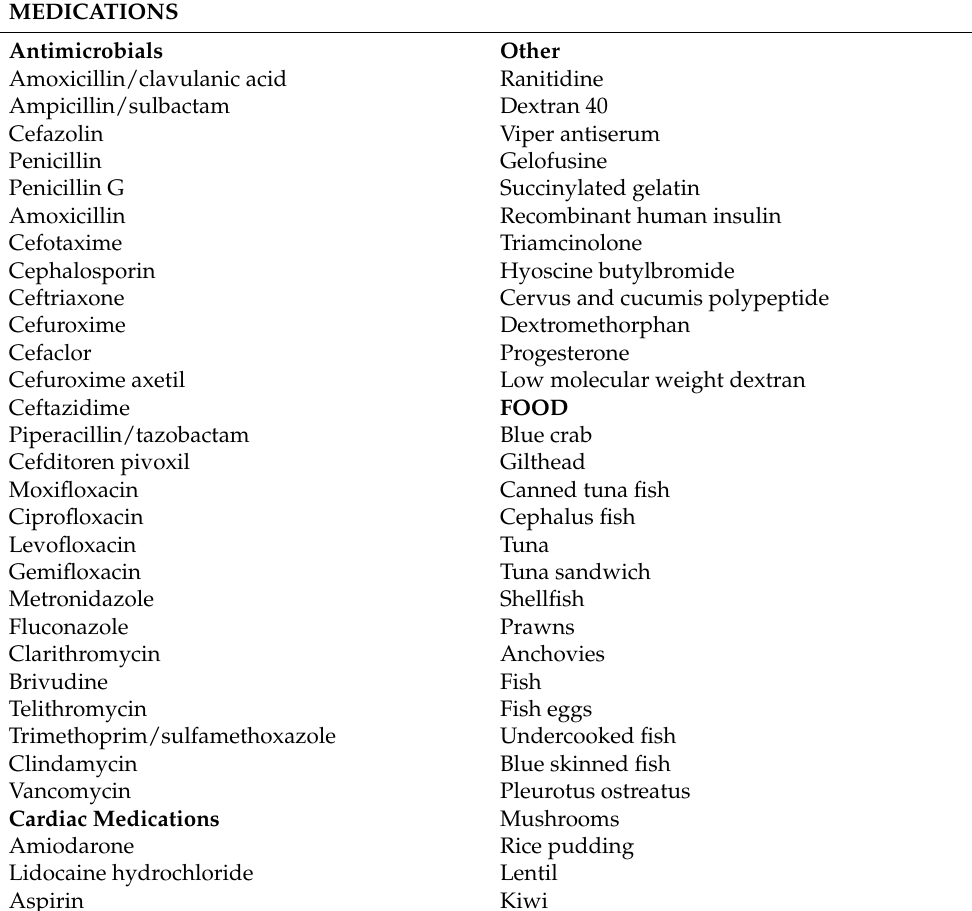
Table 4. Detailed list of all previously identified